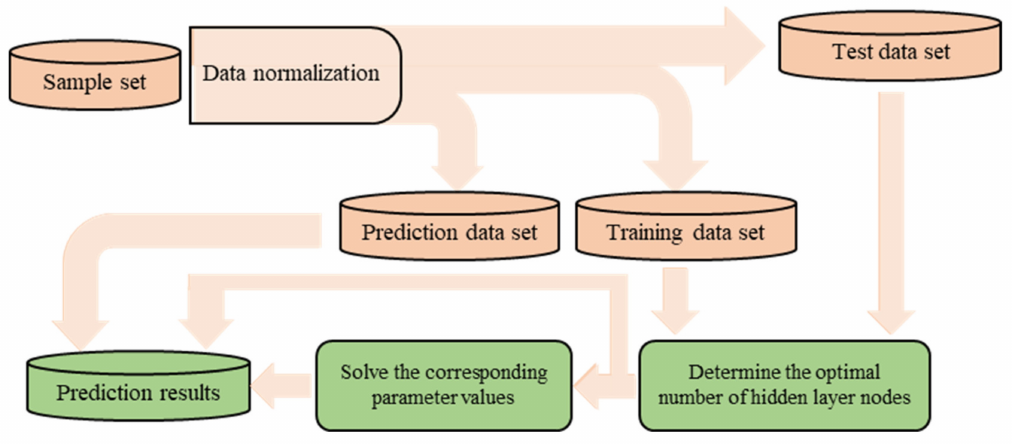
Figure 6. Schematic of the ELM algorithm prediction